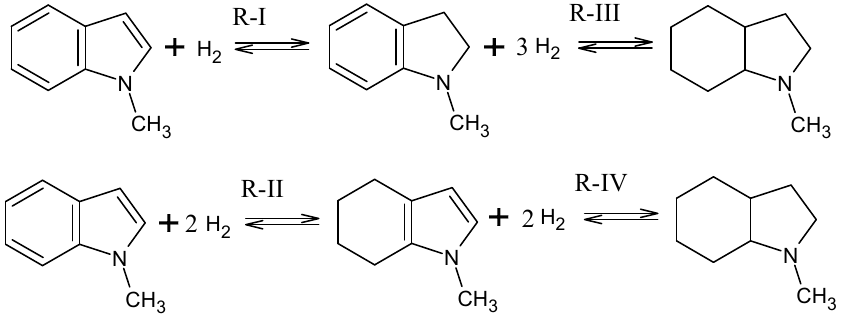
Figure 2. Equilibria of hydrogenation reactions for the 1-methyl-indole/octahydro-1-methyl-indole LOHC system.